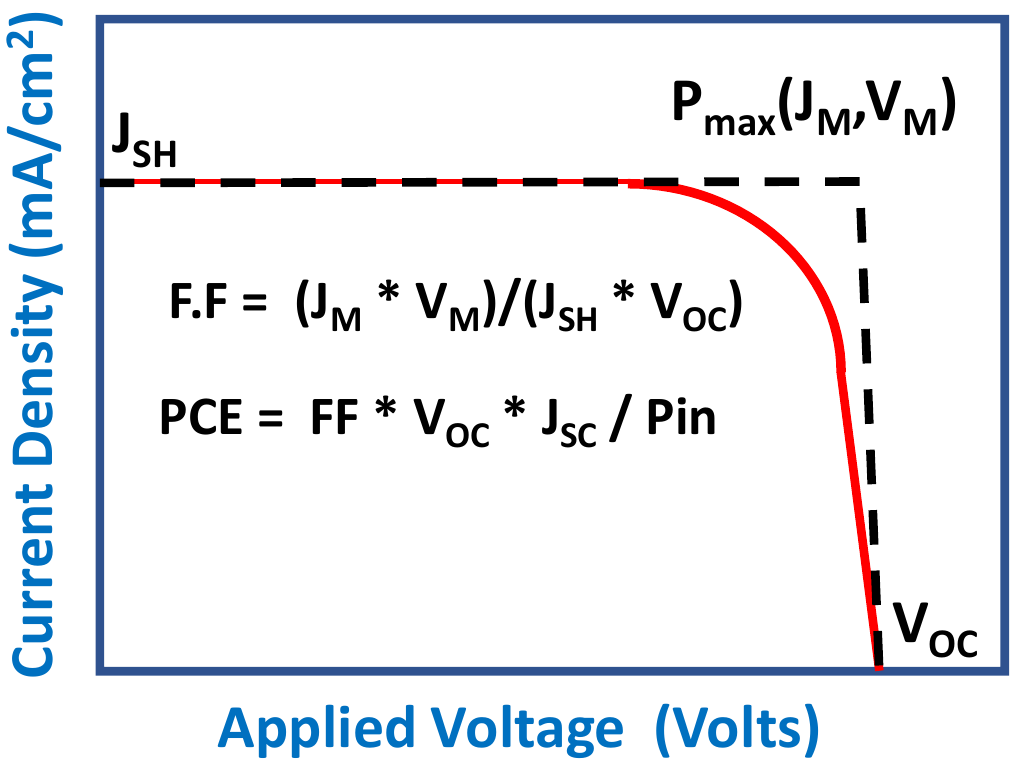
Figure 7. Power-conversion efficiency as a function of short-circuit current, open-circuit voltage and fill-factor for a solar